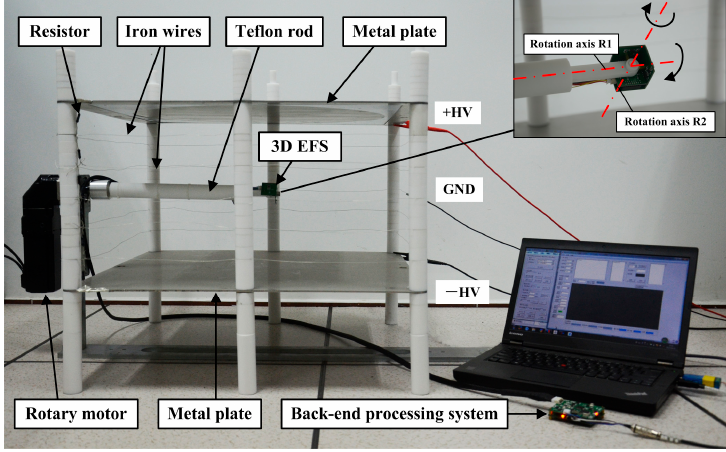
Figure 10. Calibration system. The size of uniform electric field space is 60 cm × 60 cm × 30 cm.